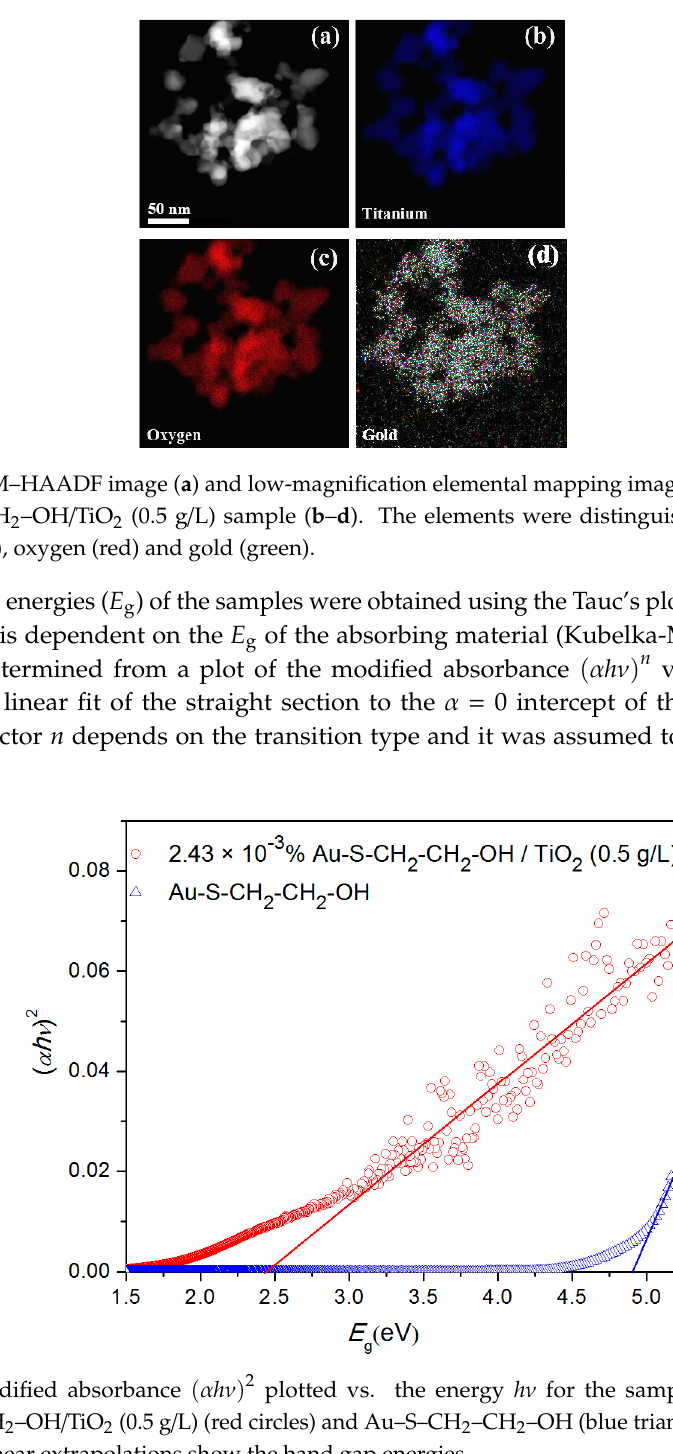
2 )( να h Figure 4. Modified absorbance plotted vs. the energy h ν for the samples 2.43 × 10 − 3 % Au–S–CH 2 –CH 2 –OH/TiO 2 (0.5 g/L) (red circles) and Au–S–CH 2 –CH 2 –OH (blue triangles). The colored lines are the linear extrapolations show the band gap energies.